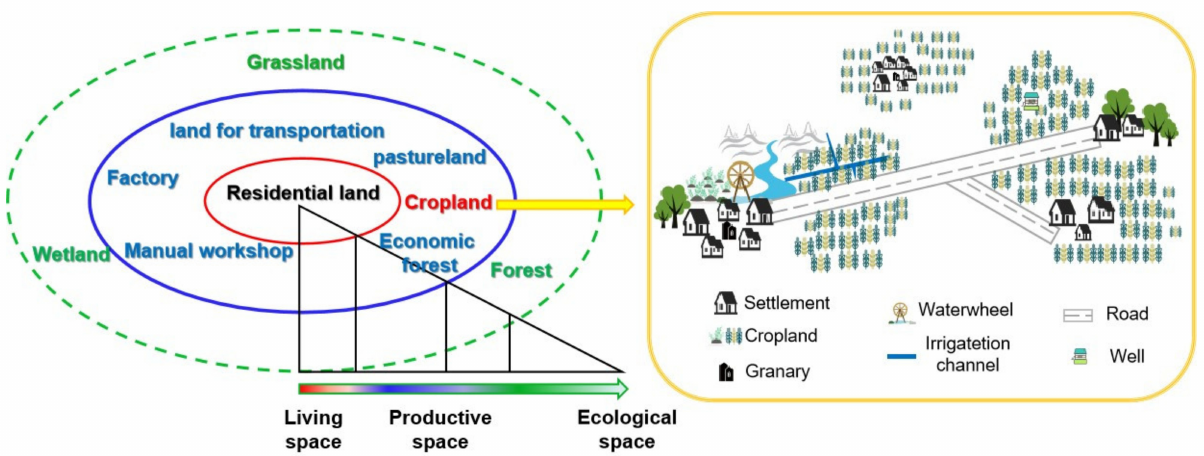
Figure 2. The spatial distribution of land used for production, living, and ecological services and a sketch map of human factors relating to the distribution of cropland.